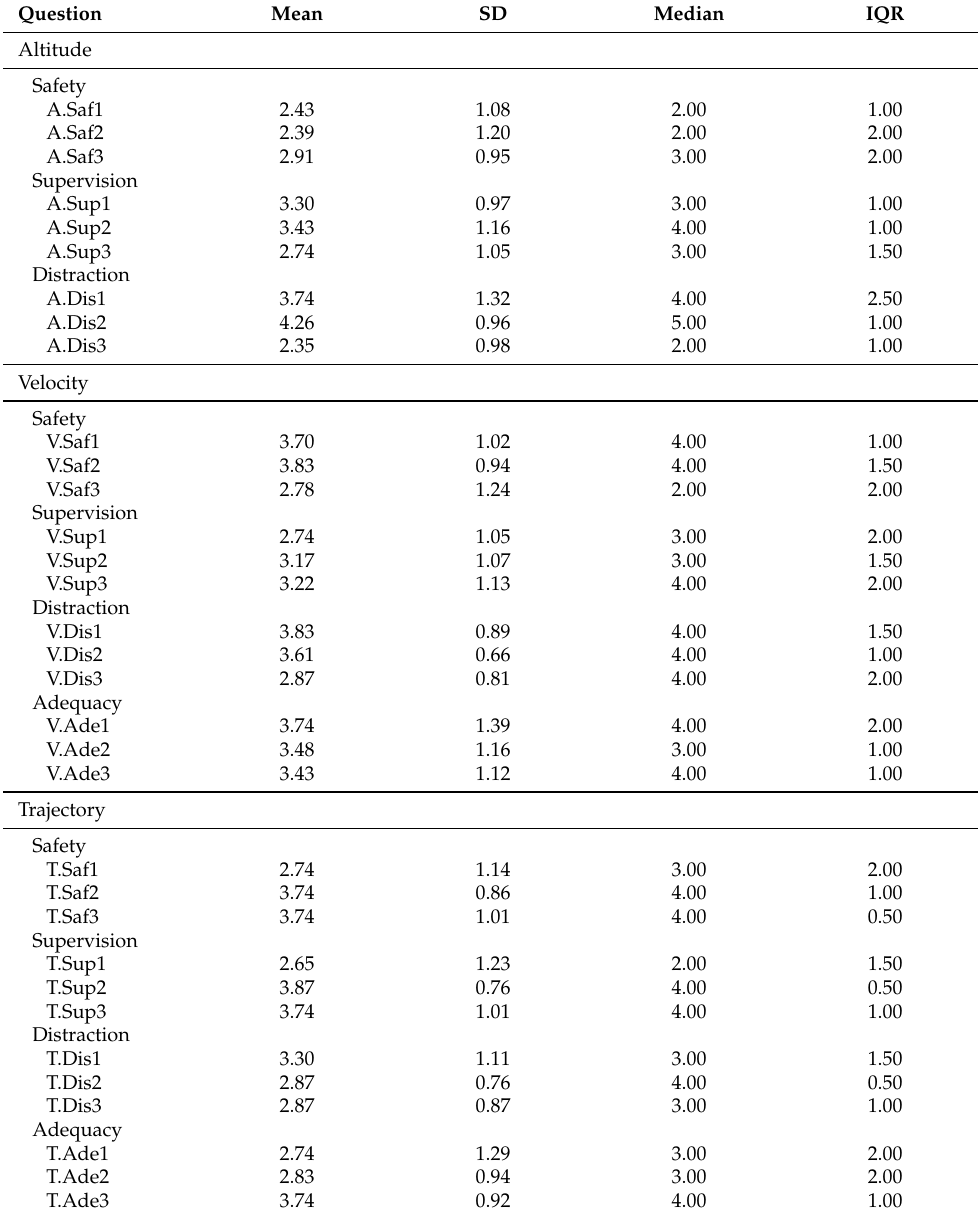
Table 6. Questionnaire and participants’ responses for the second experiment with older